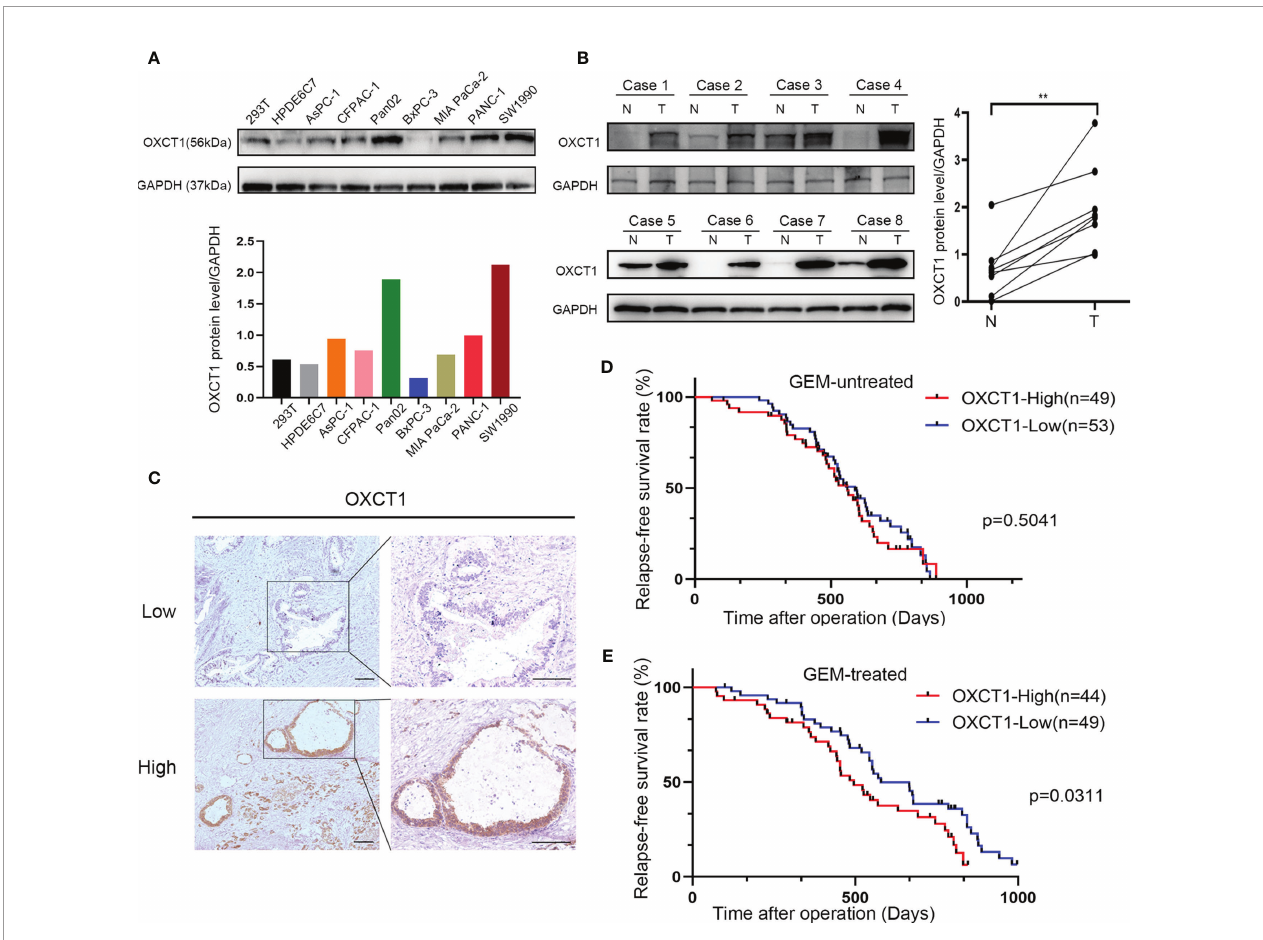
FIGURE 2 | High OXCT1 expression in patients with PDAC treated with GEM predicted poor RFS. (A) Basal expression levels of OXCT1 in seven classical pancreatic cancer cell lines, a human pancreatic ductal epithelial cell line (HPDE6C7), and 293T cell line were analyzed through western blot analysis. OXCT1/ GAPDH protein expression level is depicted in the histogram. (B) Western blot analysis of OXCT1 levels in eight paired PDAC tumorous and adjacent normal pancreatic tissues (T, tumor tissues; N, normal tissues). The corresponding statistics are presented in the line chart. (C) Immunohistochemical analysis of OXCT1 protein expression in PDAC specimens. (D) Association between tumor OXCT1 expression levels and RFS in 102 patients with PDAC who were not treated with GEM ( P = 0.5041 based on log-rank test). (E) Association between specimen OXCT1 expression levels and RFS in 93 patients with PDAC who were treated with GEM ( P = 0.0311 based on log-rank test). ** P <